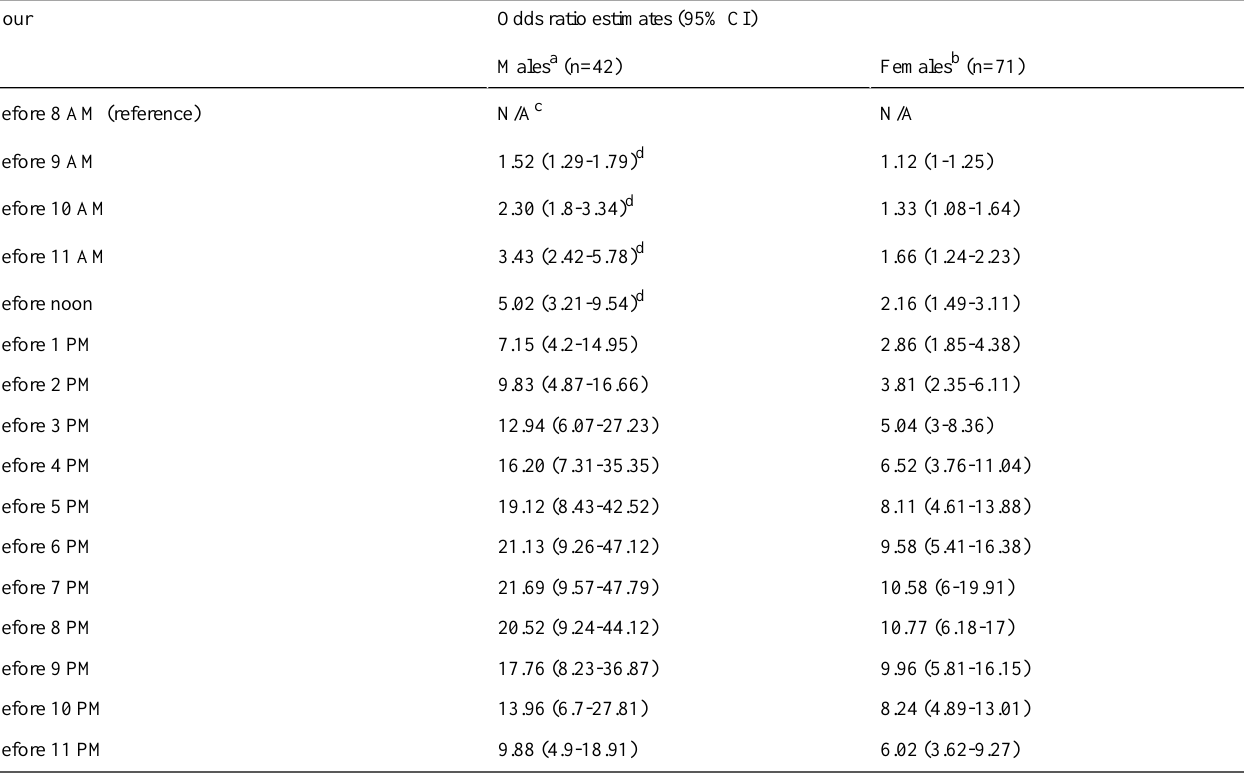
Table 2. Moderating effect of sex on odds ratio estimates of time of average moderate-to-vigorous physical activity accumulation.